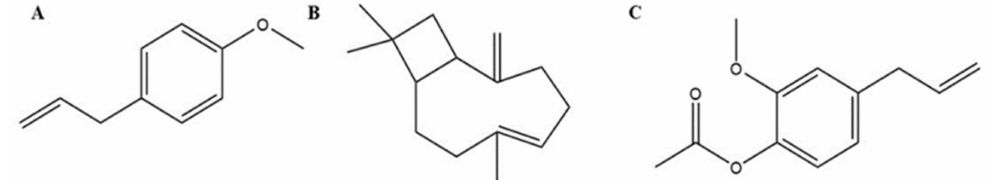
Figure 3. Chemical structures of ( A ) methyl chavicol, ( B ) beta-caryophyllene and ( C ) eugenyl acetate. Sinapis alba (white or yellow mustard) and Sinapis nigra (black mustard) both